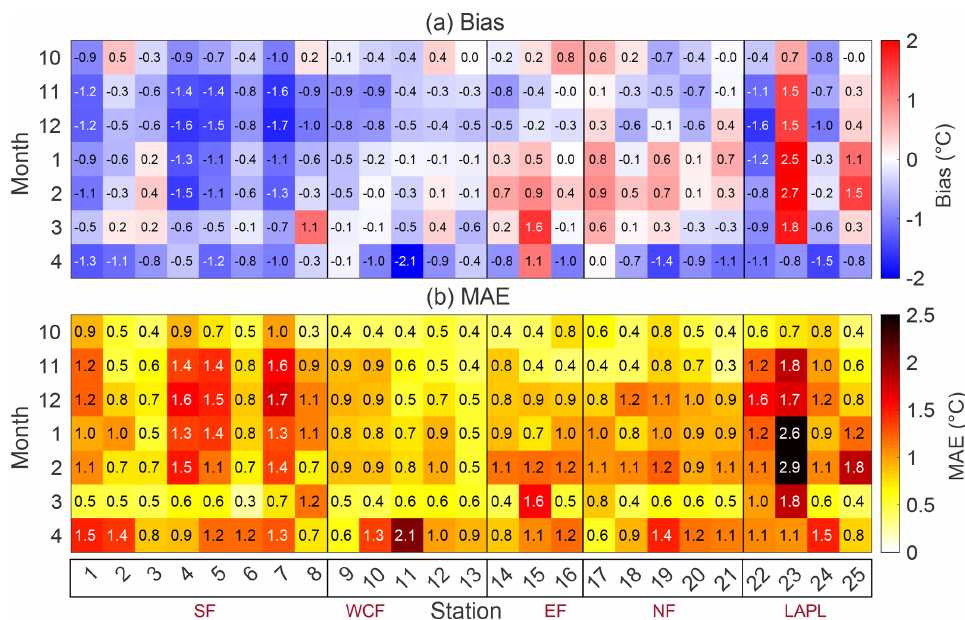
Figure 9. (a) The mean monthly biases and (b) MAE values of simulated road surface temperature between October and April in 2002–2014. The station indices on the x axis refer to Table 1. SF refers to Southern Finland, WCF to Western and Central Finland, EF to Eastern Finland, NF to Northern Finland, and LAPL to Lapland.